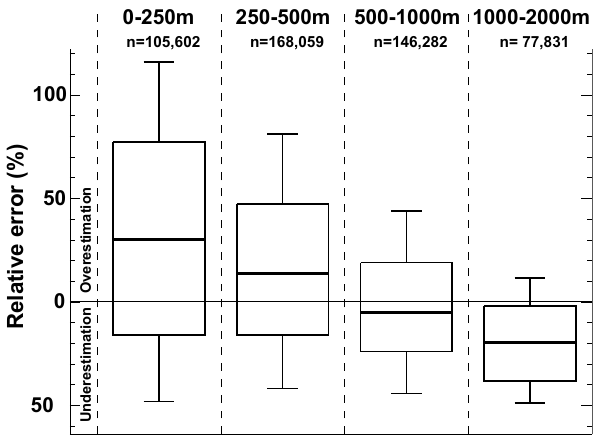
Figure 5. Relative model error for classes of n OIB ice thickness measurements. The solid line shows the median, the box includes 50% of the data points, and the bars indicate the range between the 10% and the 90%